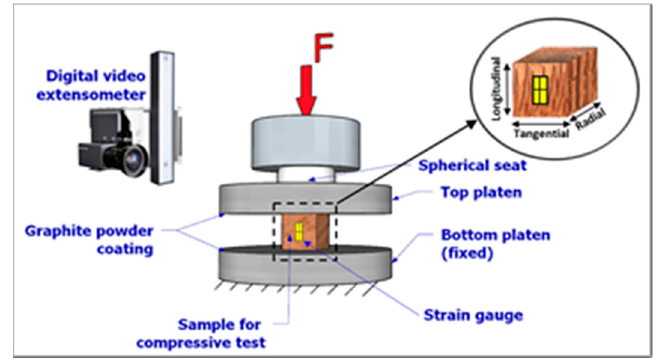
Figure 2. Compressive sample test set-up.